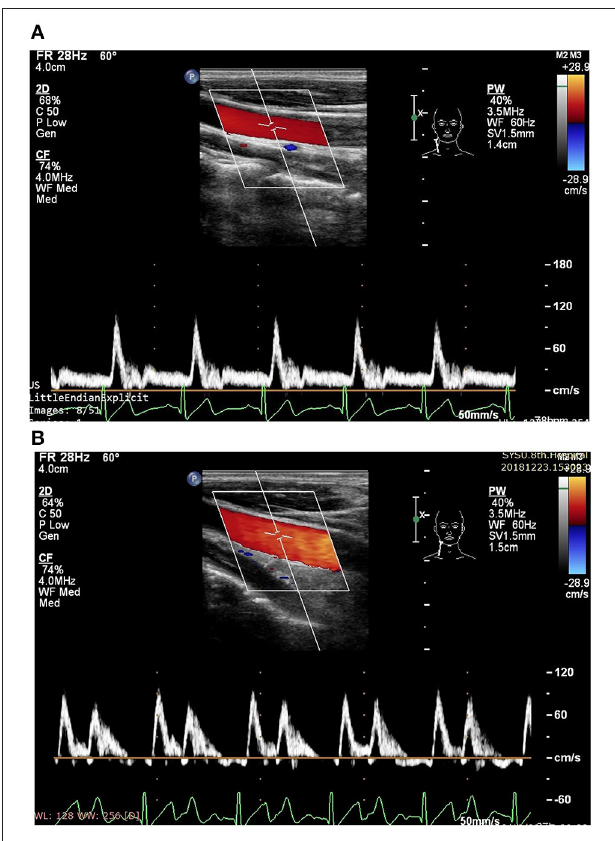
FIGURE 2 | Measurement of blood flow velocity spectrum in the right brachial (RB) artery ( A before EECP and B during